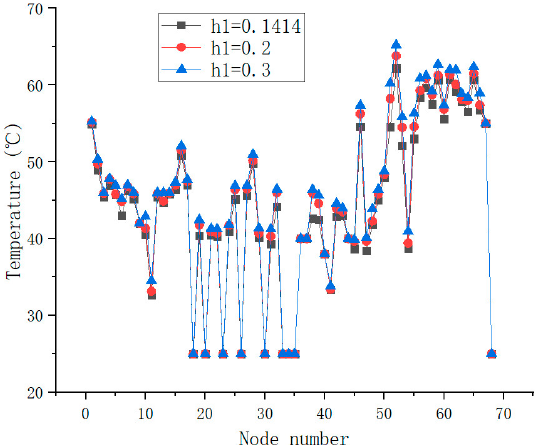
Figure 12. The TFD with the different thermal transfer coefficients of the lubricating oil.